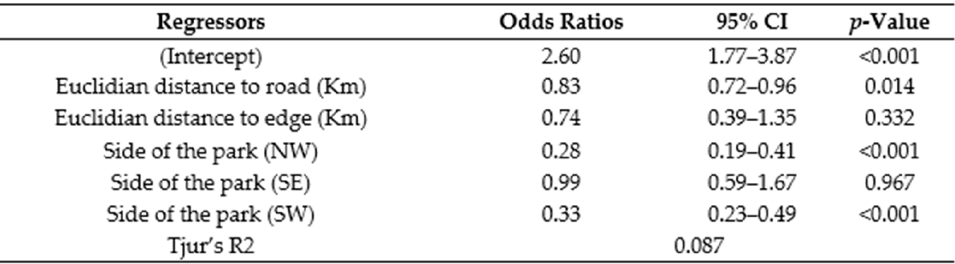
Figure A6. Multiple logistic regression between type of illegal activities, Euclidian distances to the road and the edge, and sides of Sebitoli area, Kibale National Park.